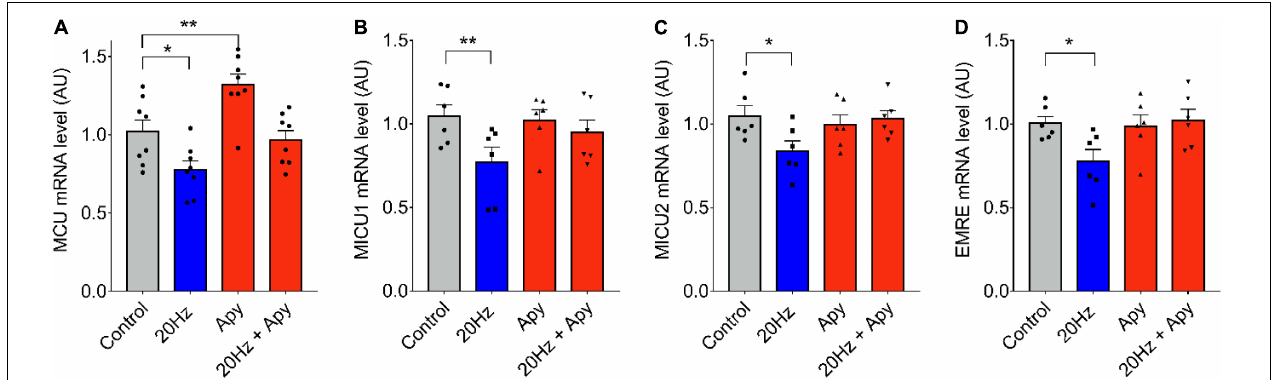
FIGURE 2 | Low-frequency ES-dependent reduction in mRNA levels of MCU complex is dependent on extracellular ATP. Muscle fibers isolated from the fdb muscle were pre-incubated 30 min with apyrase (2 U/ml) before ES (as in Figure 1 ). The mRNA was extracted 1 h after the ES. MCU mRNA levels increased with pre-incubation with apyrase in the absence of ES (A) . Preincubation with apyrase prevented the low frequency-dependent reduction in mRNA levels of MCU ( n = 8) (A) , MICU1 ( n = 6) (B) , MICU2 ( n = 6) (C) , and EMRE ( n = 6) (D) . Values are presented as mean ± SEM. 18s was used as normalizer. * p < 0.05; ** p < 0.01; *** p <